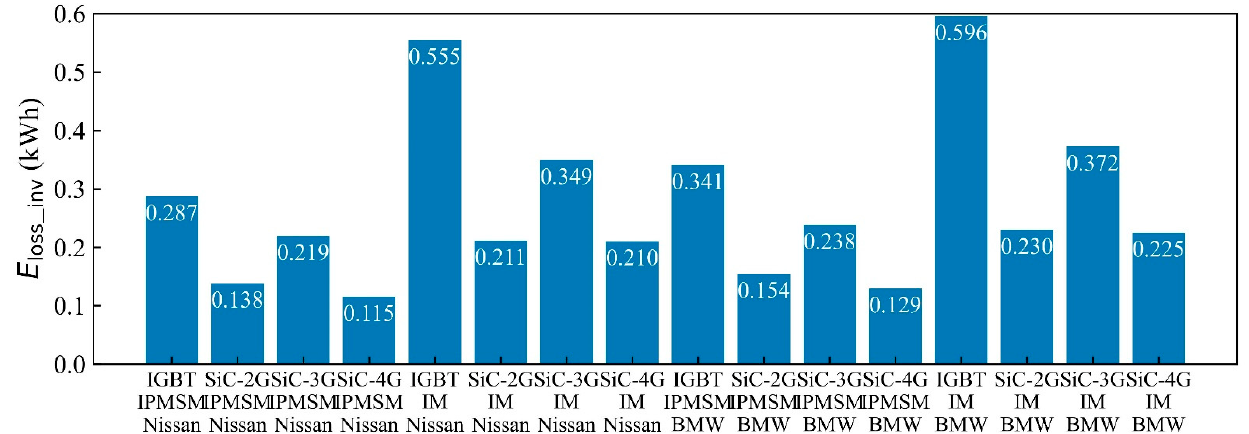
Figure 4. Inverter loss comparison between experimental cases.